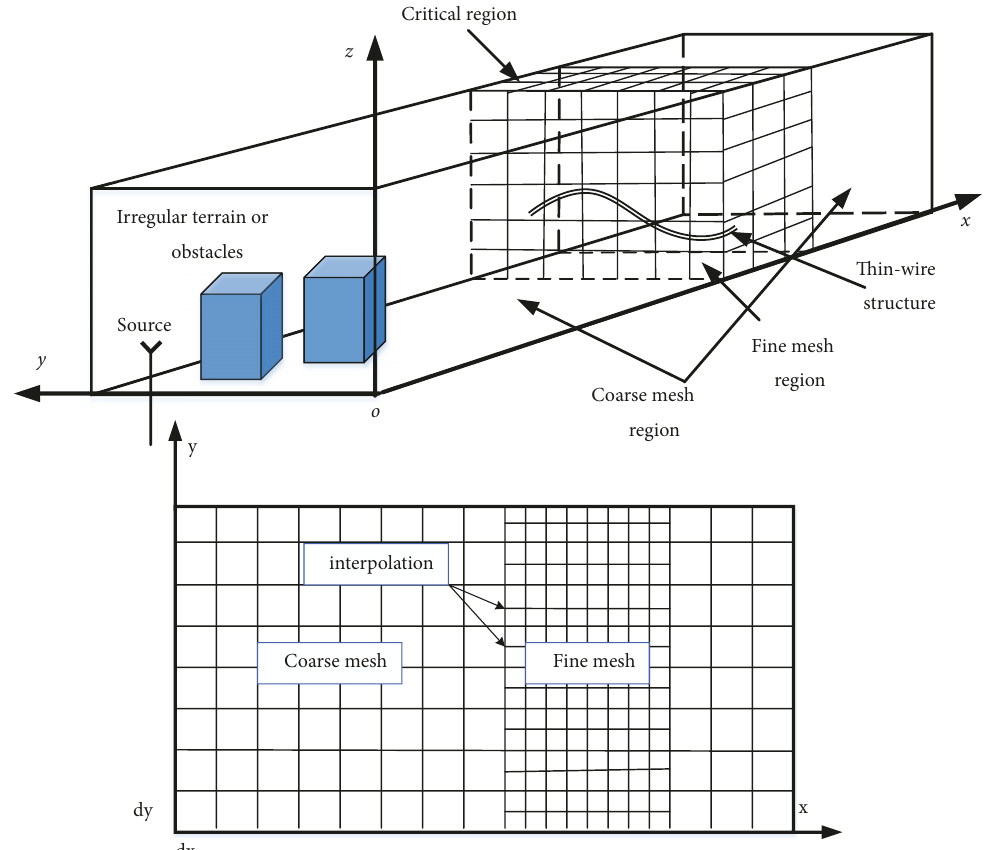
Figure 2: Hybrid algorithm with nonuniform mesh technique. Coarse and fine grids are applied to different regions.